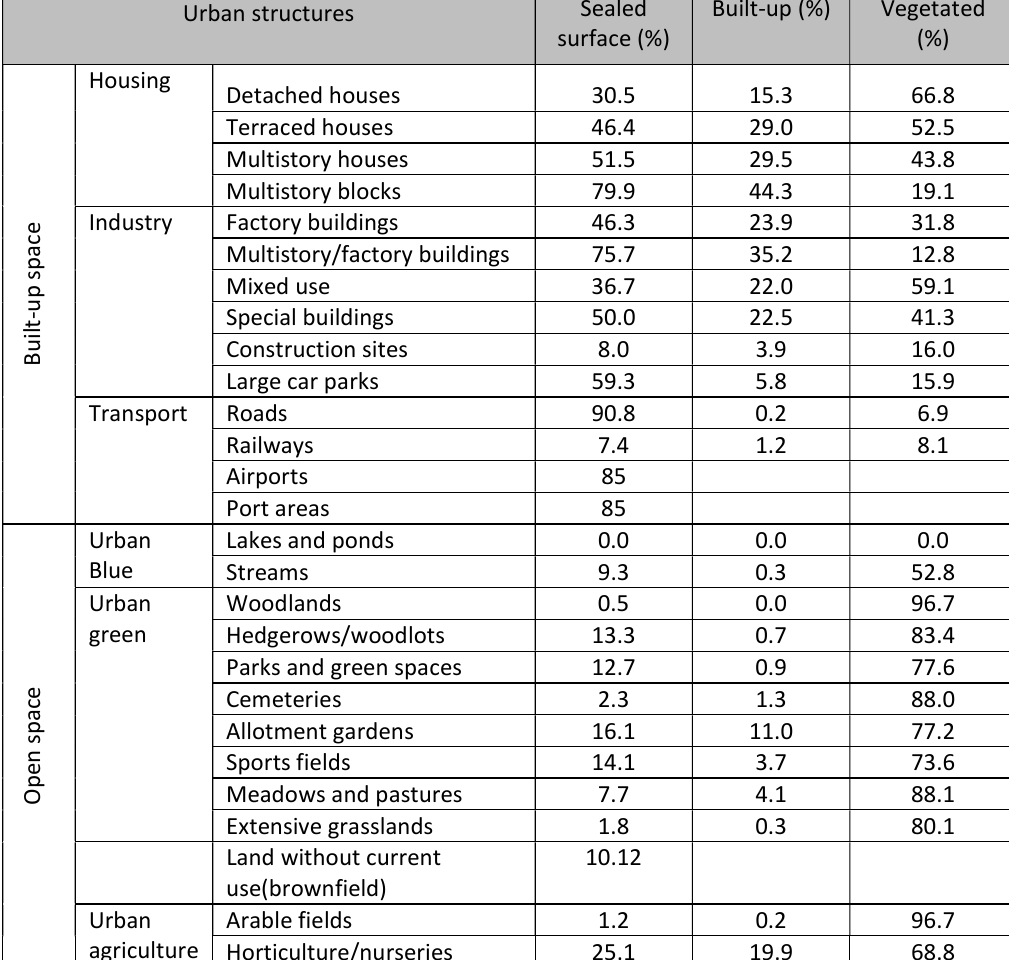
Table 1: Overview of the urban structures including built-up spaces and open spaces. % refer to the mean percentage shares of unit area. Adapted after Haase & Nuissl (2010), Urban Atlas data base (Larondelle et al., 2014a) and Pauleit & Duhme